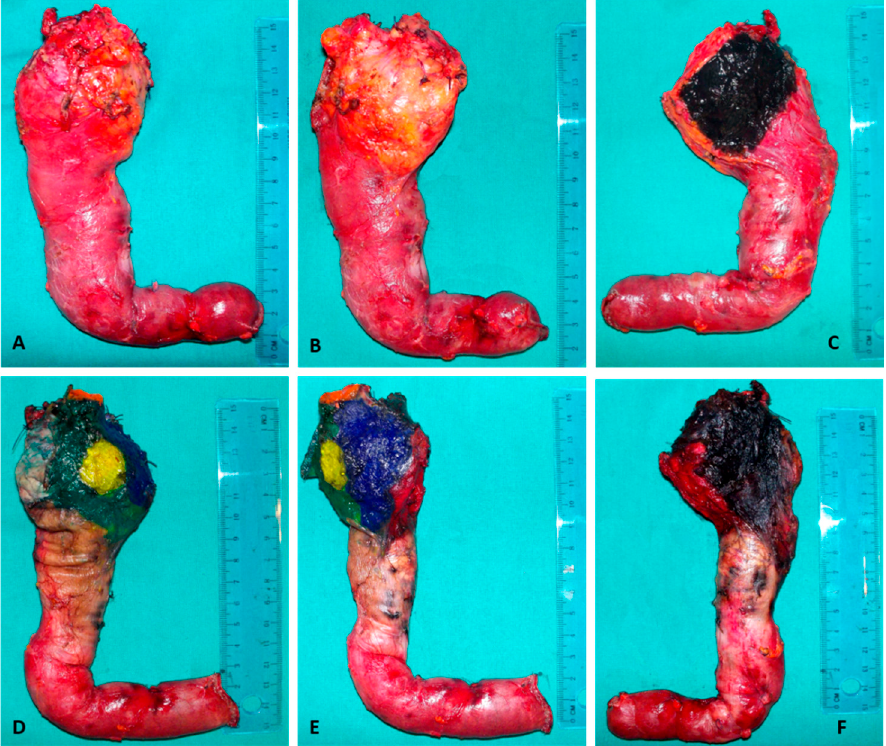
Figure 2. Evaluation of resection margins in PD specimens. ( A – C ) Pancreaticoduodenectomy specimen in Group B (“conventional protocol): ( A ) View of anterior surface. ( B ) View of medial surface. ( C ) View of posterior surface: the posterior margin (variably defined as uncinate margin or retroperitoneal margin) is inked in black. ( D – F ) Pancreaticoduodenectomy specimen in Group A (LEEPP protocol). The resection margins are painted in different colors: ( D ) View of anterior surface. The anterior margin is inked in green. ( E ) View of medial surface. The medial margin includes superior mesenteric vein margin inked in blue and superior mesenteric artery margin inked in red. In this image is also visible the pancreatic stumps inked in yellow and the bile duct stump in orange. ( F ) View of posterior surface painted in black.